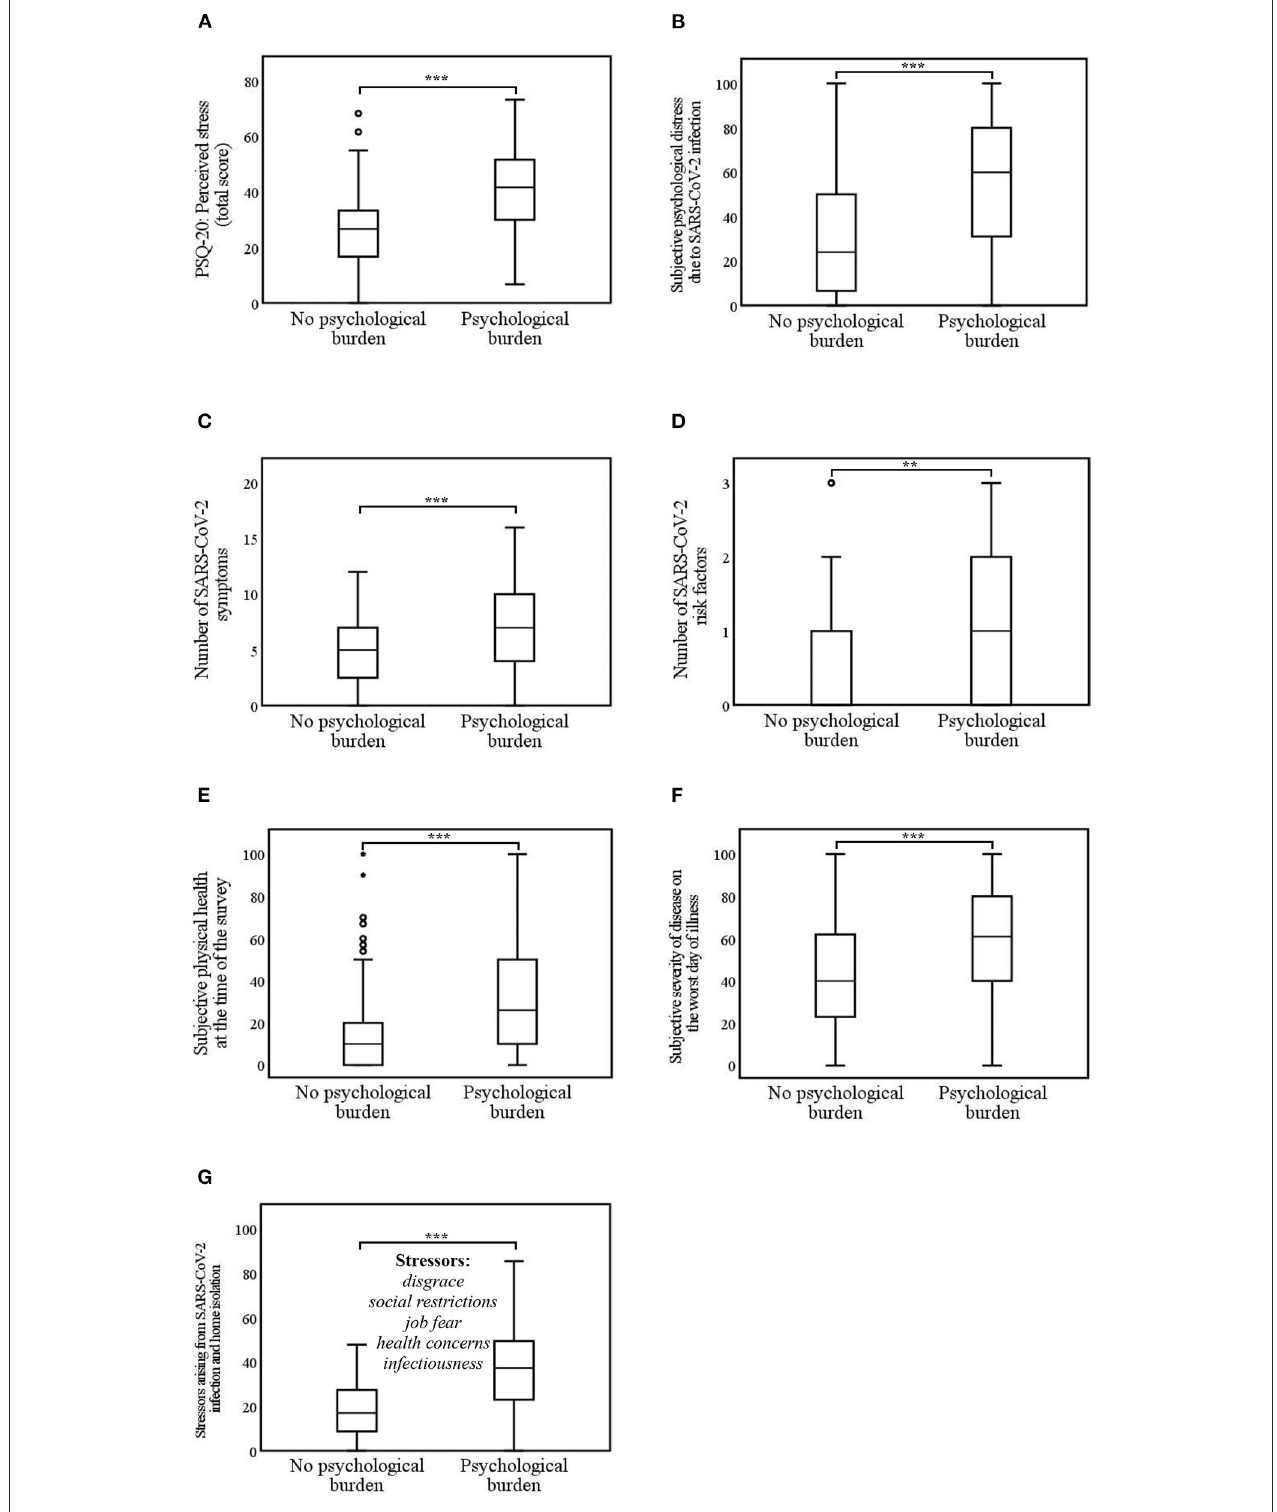
FIGURE 3 | (A–G) Differences in stress experience due to psychological burden during SARS-CoV-2 infection and home isolation. Psychological burden = home-isolated SARS-CoV-2 infected individuals with somatic symptom disorder and/or depressive symptoms and/or anxiety. ** p < 0.01; *** p < 0.001. (A) 0 = low perceived stress to 80 = high perceived stress; (B) 0 = very low stress level to 100 = very high stress level; (E,F) 0 = not ill at all to 100 = very severely ill; (G) 0 = not stressed at all to 100 = extremely stressed.